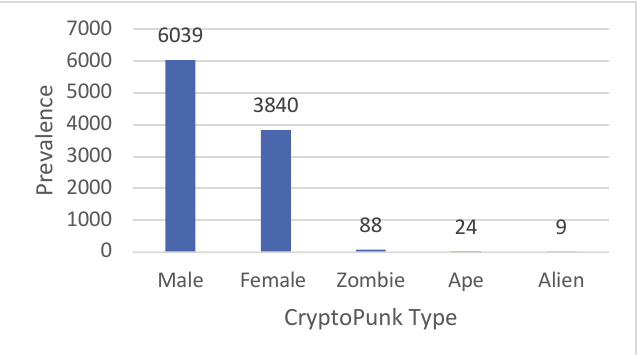
Figure 1: Prevalence of CryptoPunk Types